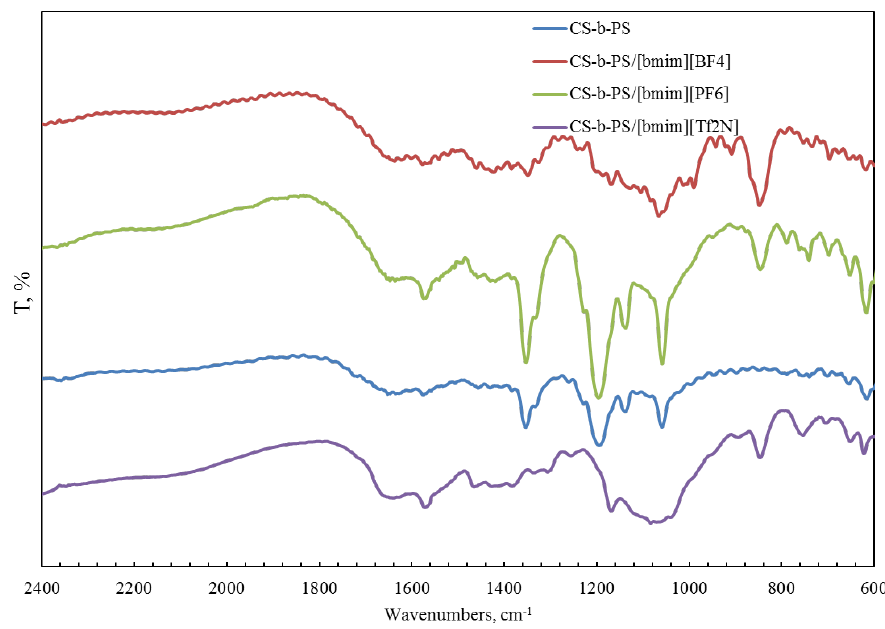
Figure 4. FTIR spectra of pure CS-b-PS copolymer and CS-b-PS copolymers doped with IL.